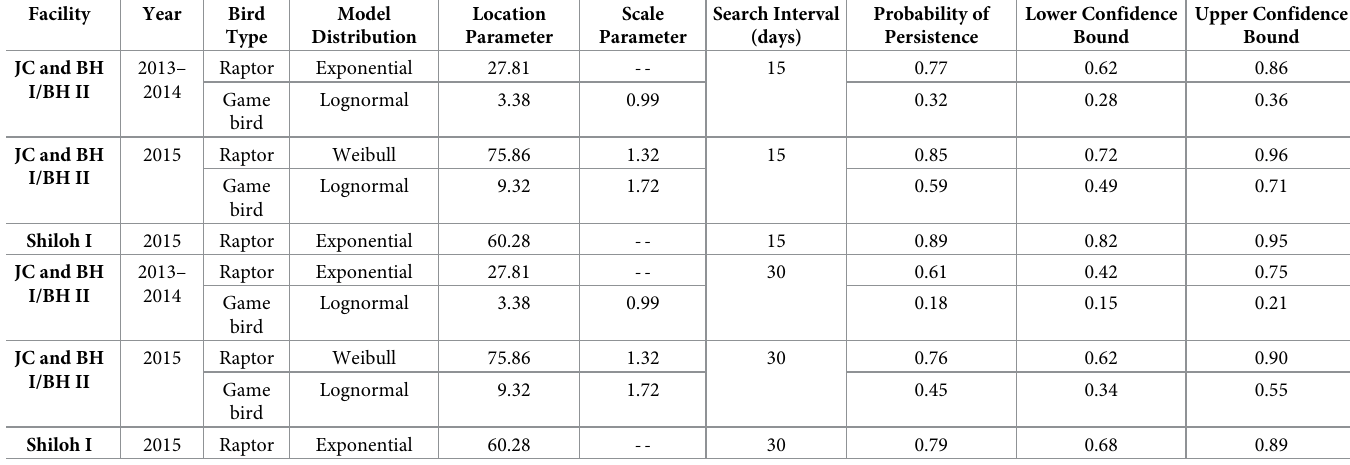
a Confidence bounds are for a 90% confidence interval.